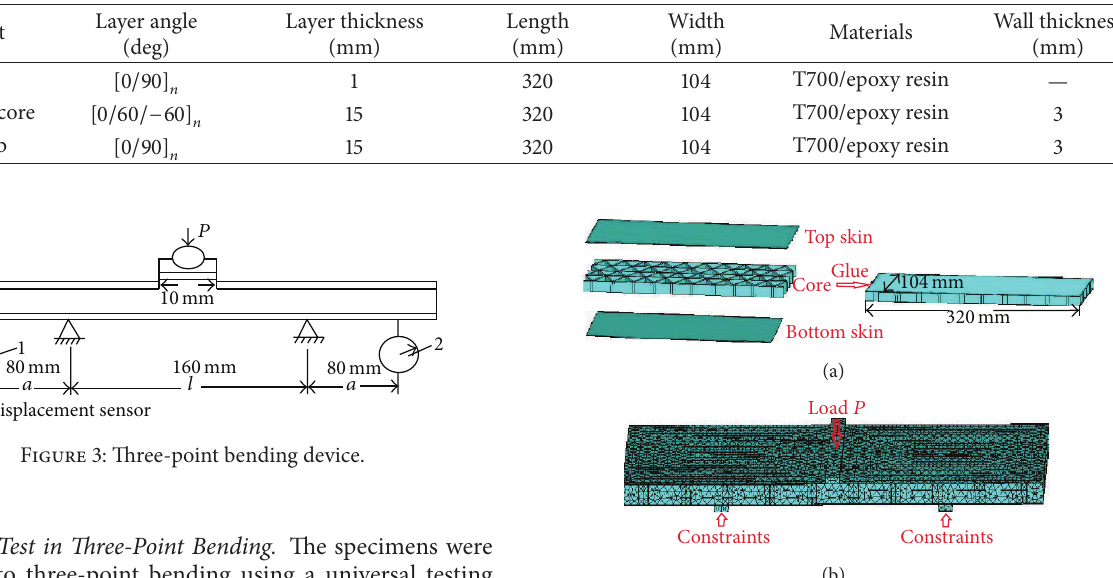
Table 2: Layer property of the sandwich structure.